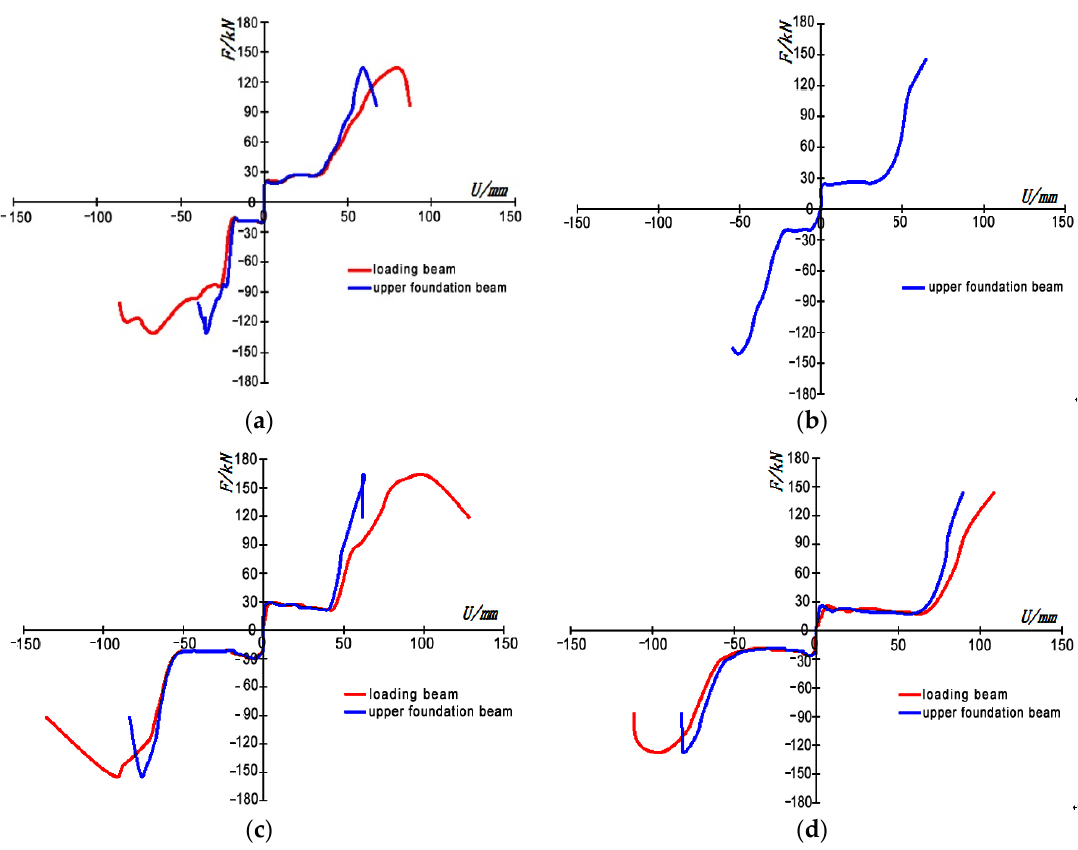
Figure 16. F ‐ U 2 hysteretic Curves: ( a ) GGBW ‐ 1; ( b ) GGBW ‐ 3; ( c ) GGBW ‐ 4.